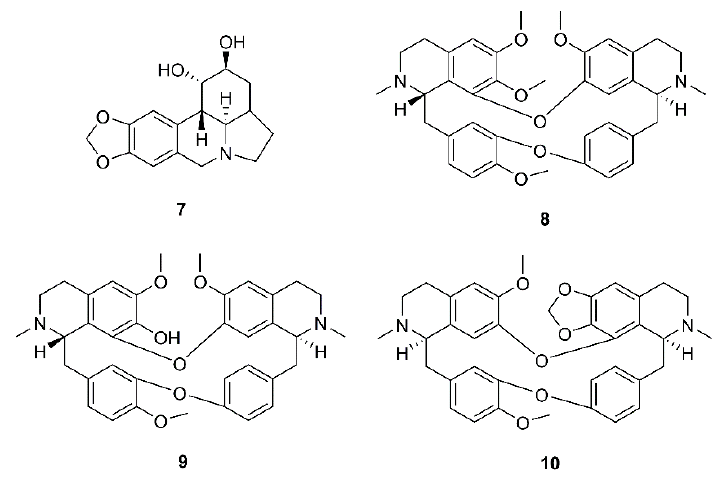
Figure 3. Structures of lycorine ( 7 ), tetrandrine ( 8 ), fangchinoline ( 9 ), and cepharanthine ( 10 ). Bis -benzylisoquinoline alkaloids tetrandrine ( 8 ), fangchinoline ( 9 ), and